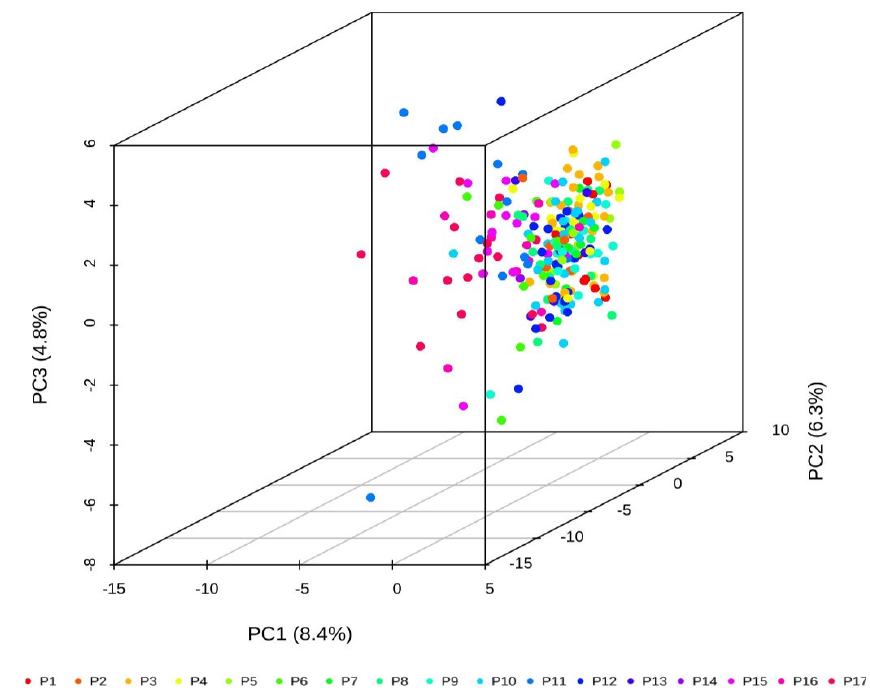
Figure 4. Principal component analysis (PCA) of 232 C. hystrix elite germplasms by https://www.bioladder.cn/web/#/chart/62. PCA plot of the first three components (PC1, PC2, and PC3) of the 232 germplasms.